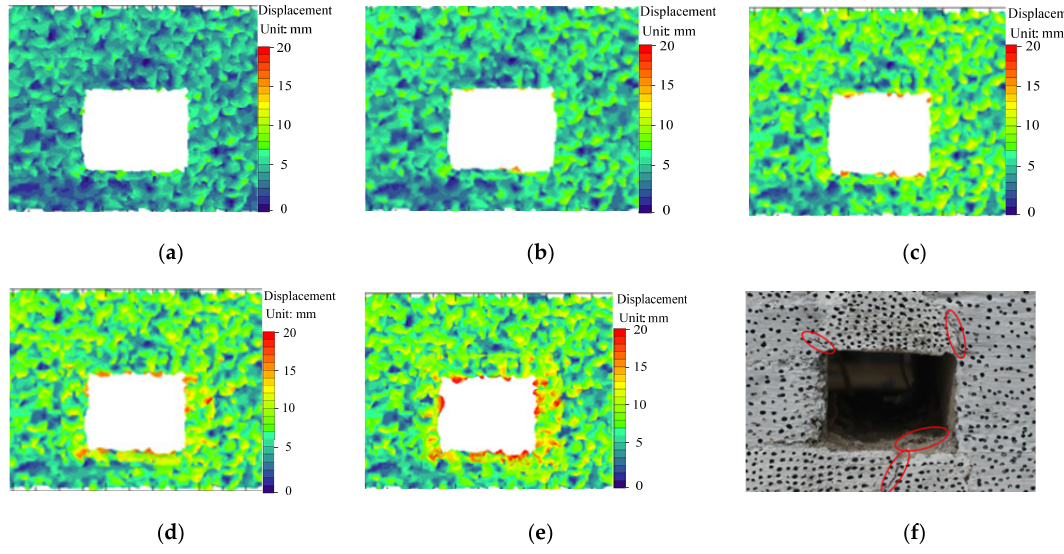
Figure 10. The displacement cloud diagrams of the surrounding rock mass at different excavation times. ( a ) After 5 min; ( b ) after 15 min; ( c ) after 25 min; ( d ) after 35 min; ( e ) after 45 min; ( f ) final failure image.